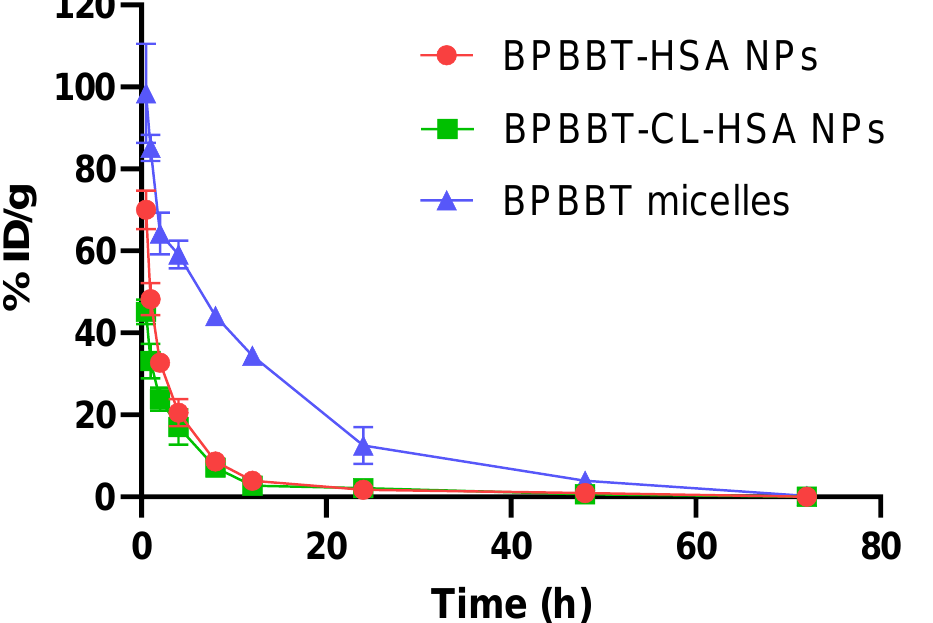
Figure 3. The plasma concentration-time curves of BPBBT in BALB/c mice bearing CT26-Luc orthotopic tumor after i.v. administrated with BPBBT-HSA NPs, BPBBT-CL-HSA NPs or BPBBT micelles (20 mg/kg of BPBBT). Data are presented as mean ± SD ( n = 3).